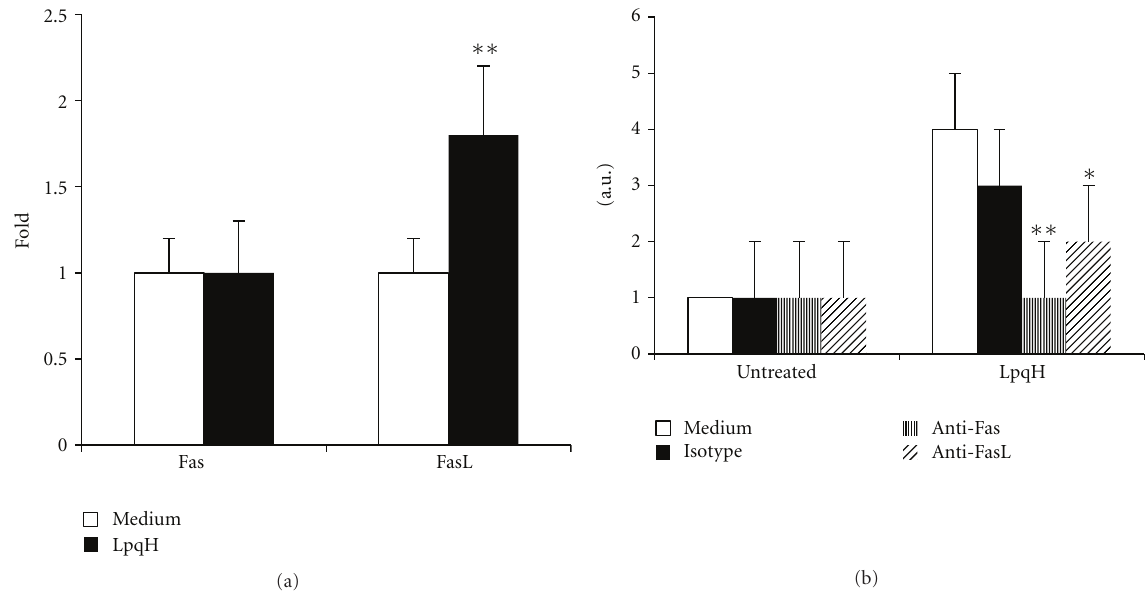
Figure 3: In the LpqH-induced apoptosis participate Fas/FasL. (a) MOs were incubated for 1h with 5 μ g LpqH and the expression of Fas and FasL was quantitated by a cell surface ELISA method using specific mAb. The relative fold increase over untreated cells (set to 1) is shown as the mean ± SE of four independent experiments; statistically significant di ff erences are indicated; ∗∗ P < 0 . 01. (b) Inhibition assays to establish the role of Fas and FasL were carried out. MOs were preincubated with neutralizing mAb to Fas and FasL. Thereafter, without rinsing, cells were incubated with 5 μ g LpqH for 1h. The mean ± SE apoptosis level of 3 independent experiments is indicated. ∗ P < 0 . 05; ∗∗ P < 0 .